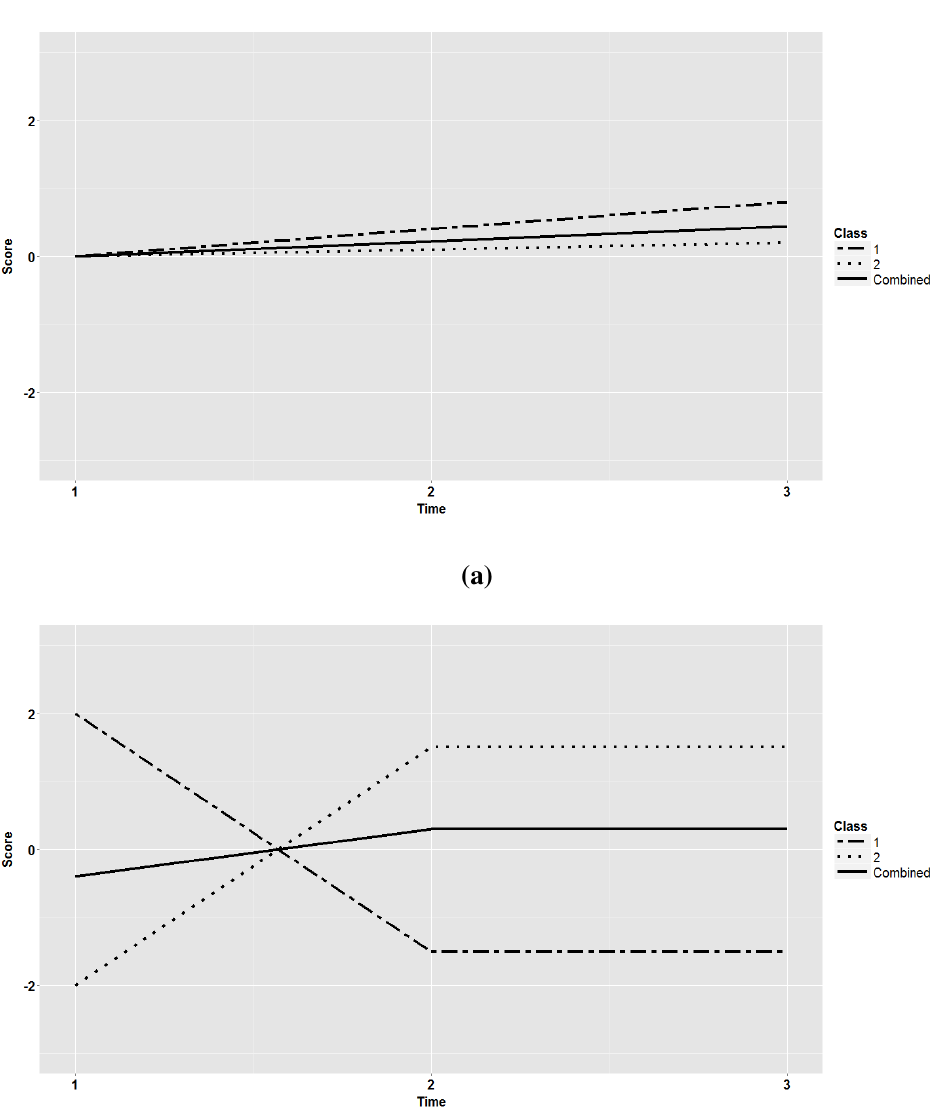
Figure 2. Class-specific and combined growth models. ( a ) Linear (non-crossing) growth model; ( b ) quadratic (crossing) growth